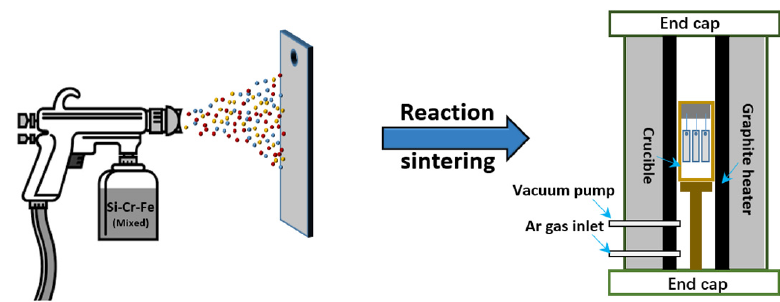
Figure 1. Flow chart of coating preparation by the slurry method.